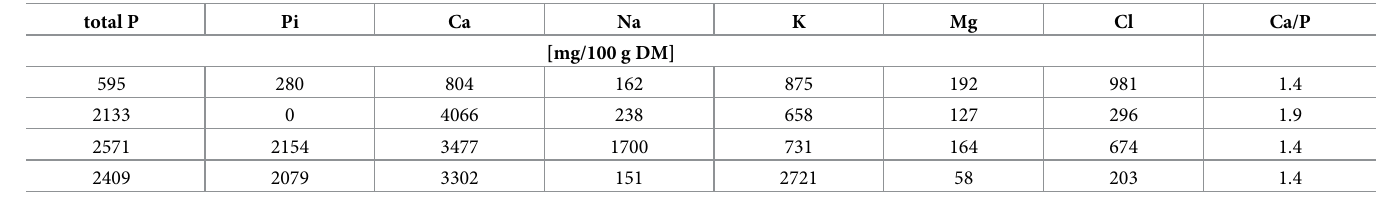
Table 2. Content of minerals, total P and P from inorganic sources (Pi), and Ca/P ratio in the control diet (CON) and 3 high phosphorus diets, containing either poultry carcass meal (HPCM), NaH